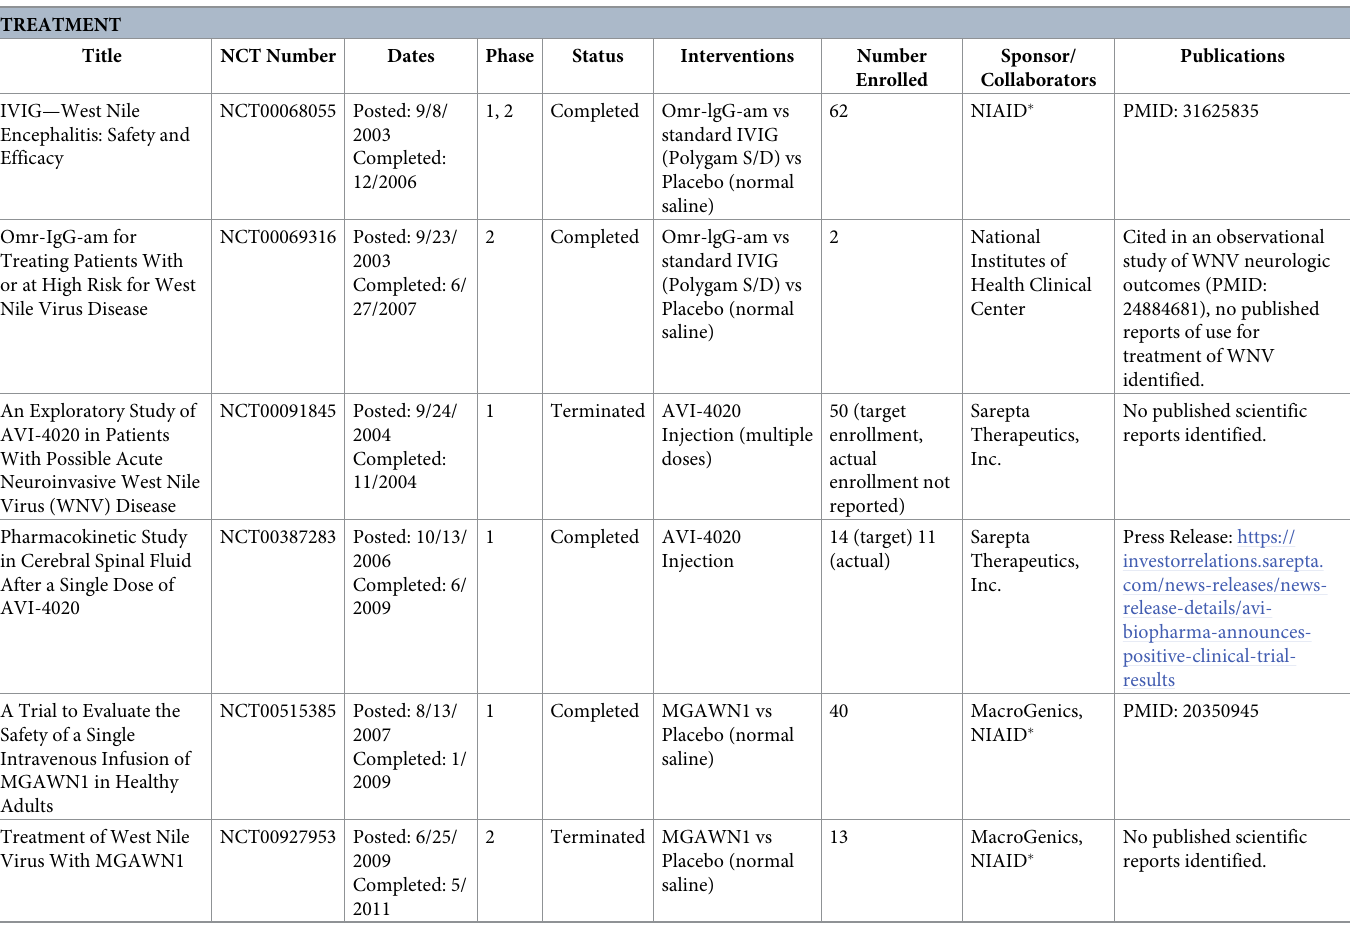
Table 2. Treatment trials for